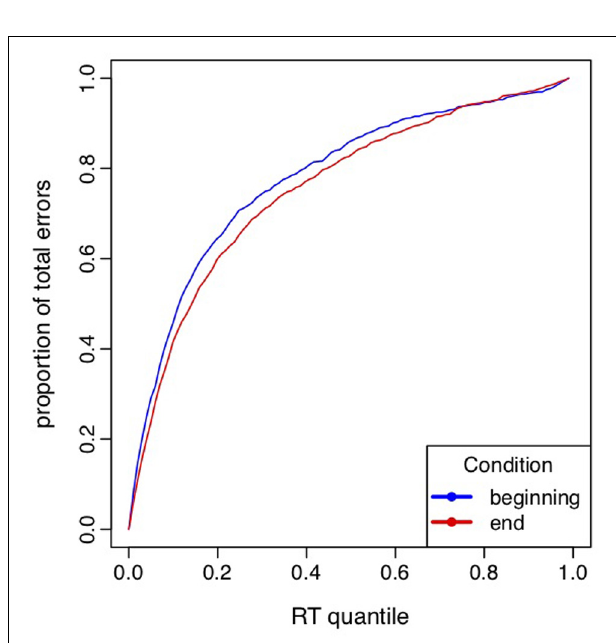
FIGURE 3 | Error location function (ELF) curves aggregated across subjects in the first three blocks (beginning; blue) and the last three blocks (end; red). Error location index represents the area under ELF